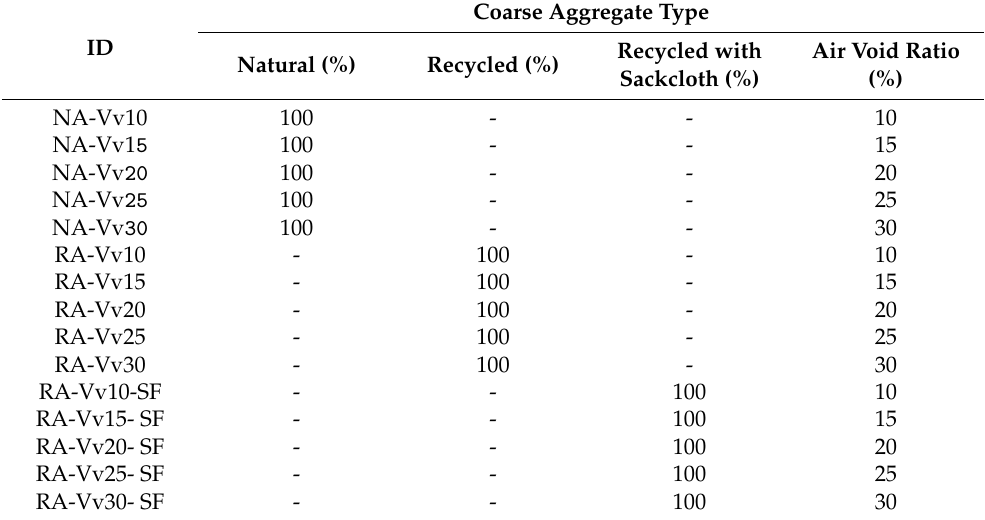
Table 1. Details of test specimens.